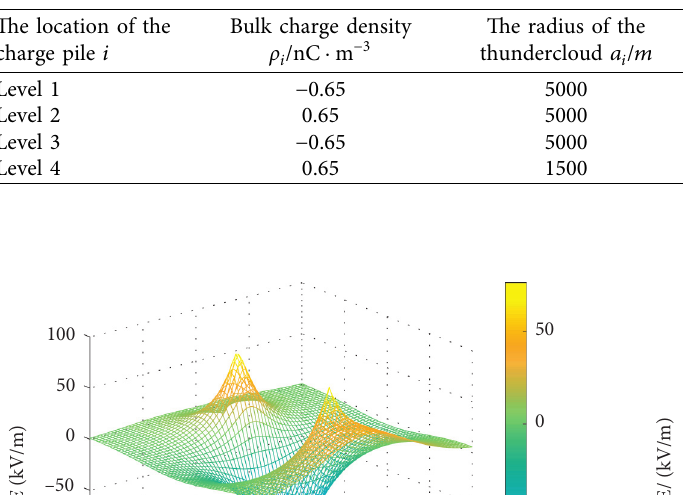
Table 2: Four-layer charge stack parameters.